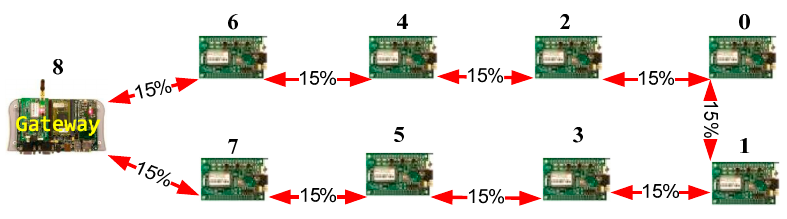
Figure 10. Circular network model example.